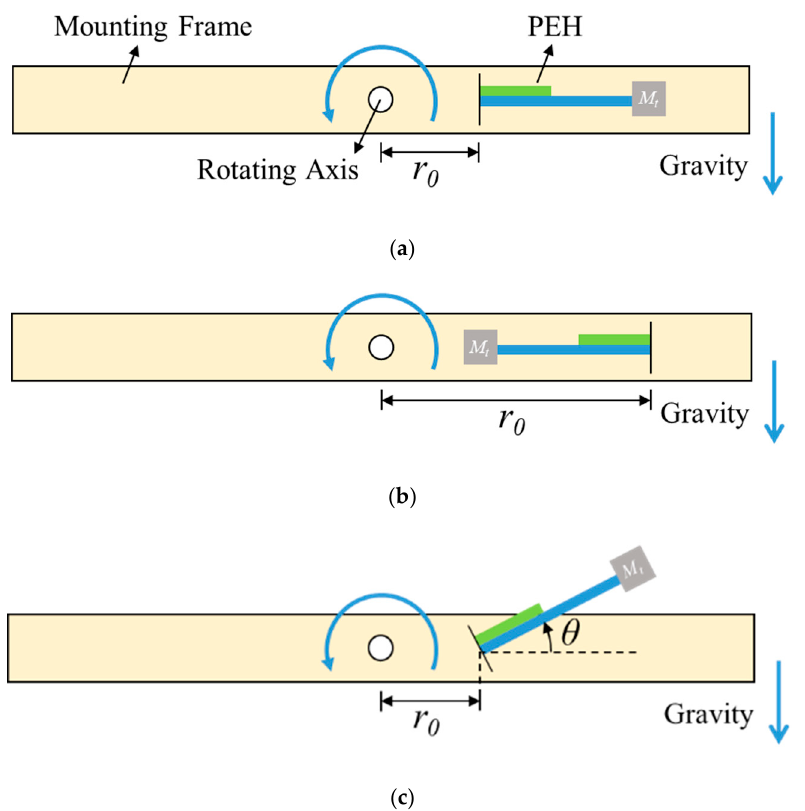
Figure 1. The piezoelectric energy harvester (PEH) under rotational motion in different orientations: ( a ) the outward configuration, ( b ) the inward configuration, and ( c ) the tilted configuration.